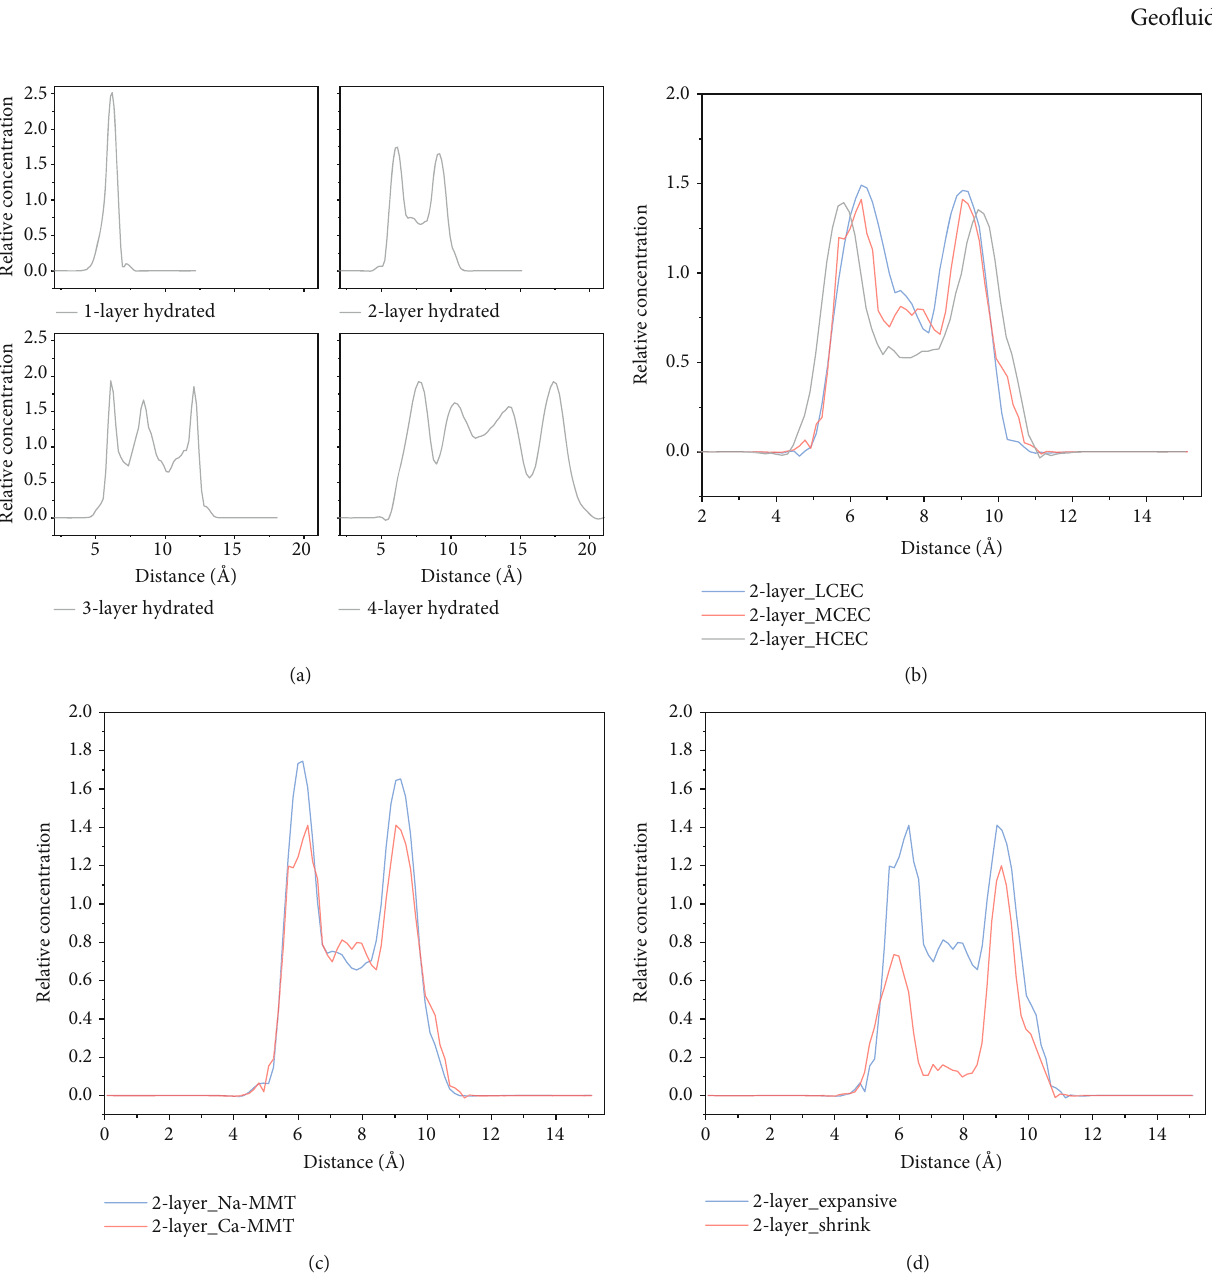
Figure 5: Distribution of water molecules along the z -axis: (a) di ff erent hydrated layers of Na-Mnt, (b) di ff erent CEC, (c) di ff erent types of interlayer cations, and (d) swelling and